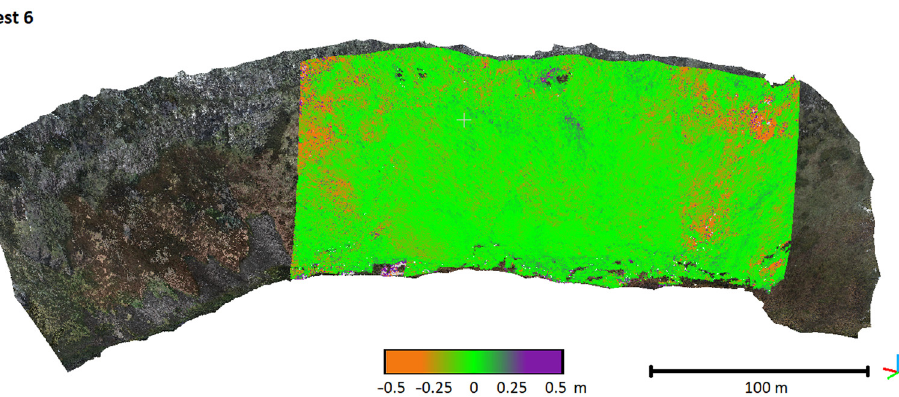
Figure 8. Spatial distribution of the cloud-to-mesh distances between the mesh resulting from the “expert dataset” (used as reference) and the point cloud corresponding to the area reconstructed by using Time-SIFT SfM photogrammetry.